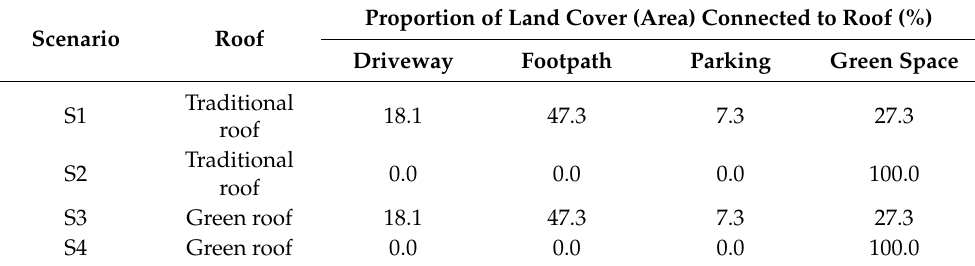
Table 5. Traditional roof, green roof, and discharge route implementation scenarios for